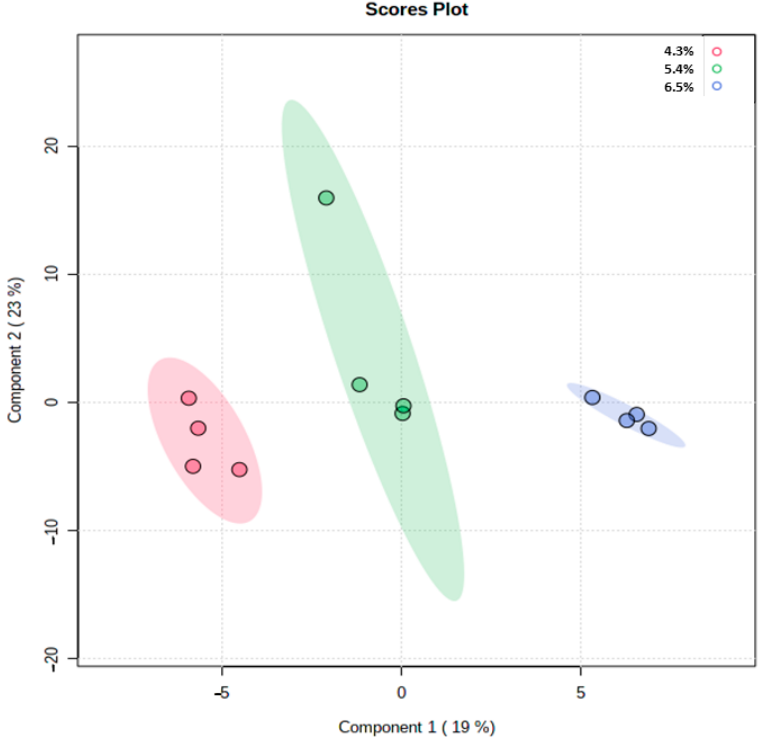
Figure 4. Partial least squares projection to latent structures and discriminant analysis based on the fecal compounds’ data among acid detergent fiber treatments.